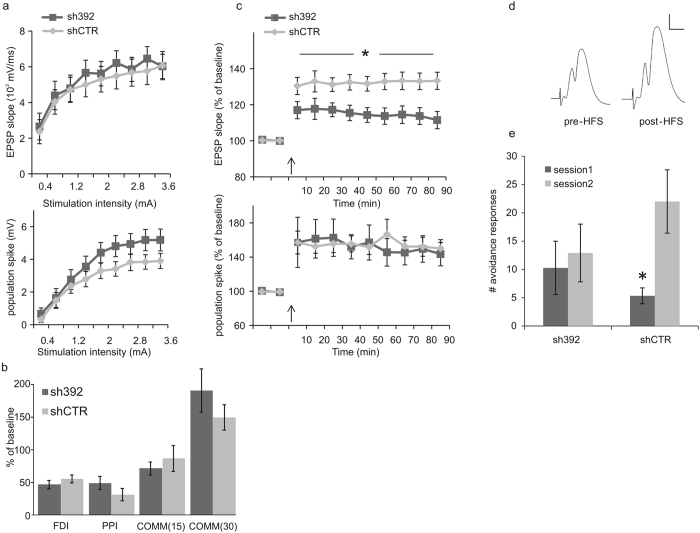
EphA7 knockdown rats impairs long-term potentiation and learning.(a) Basic excitability parameters of the dentate gyrus neuronal population (field recordings). Intrinsic excitability of the neurons (i.e. population spike; top) and synaptic excitability (i.e. EPSP slope; bottom) are enhanced with increasing stimulation amplitude applied from the perforant path. EphA7 knockdown group: n = 12; control group: n = 11. No significant differences were found between groups (p > 0.05). Error bars, S.E.M. (b) Alterations in population spikes following frequency-dependent inhibition (FDI; stimulation frequency was increased from 0.1 to 1 Hz), paired-pulse inhibition (PPI; interval between the two pulses was 15 ms), and commissural inhibition (COMM; commissural pulse preceded perforant path pulse with 15/30 ms). Data are expressed as percentage of baseline measurements, averaged for 5 (PPI and COMM) or 10 (FDI) pulses. Knockdown group: n = 12; control group: n = 11. No significant differences were found between groups (p > 0.05). Error bars: S.E.M. (c) LTP following high frequency stimulation. Potentiation of the EPSP slope (top) and population spike (bottom) following theta burst stimulation, expressed as percentage of baseline measurements. The knockdown group (n = 9) exhibits reduced slope of the EPSP in comparison to the control group (n = 8). Arrows indicate time of high frequency stimulation. *p < 0.05; error bars, S.E.M. (d) Example traces of field recordings from a control rat before (left) and after (right) theta burst stimulation. Calibration: 5 ms/2 mV. (e) Avoidance responses per session in the two way shuttle avoidance task. Control group (n = 11) improves performance in the second session, while knockdown group (n = 12) shows no such improvement. *p < 0.01; error bars: S.E.M. ANOVA.